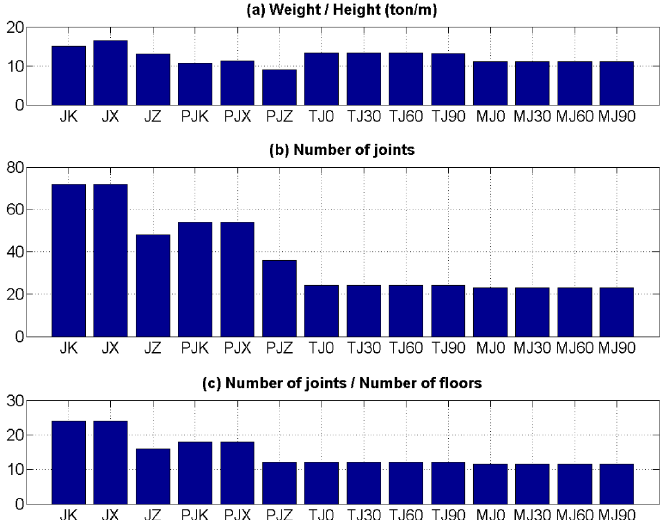
Figure 7. Comparison charts of all 14 jacket structures showing: ( a ) the ratio of the weight to height; ( b ) the number of joints; ( c ) the ratio of joint numbers to floor numbers.